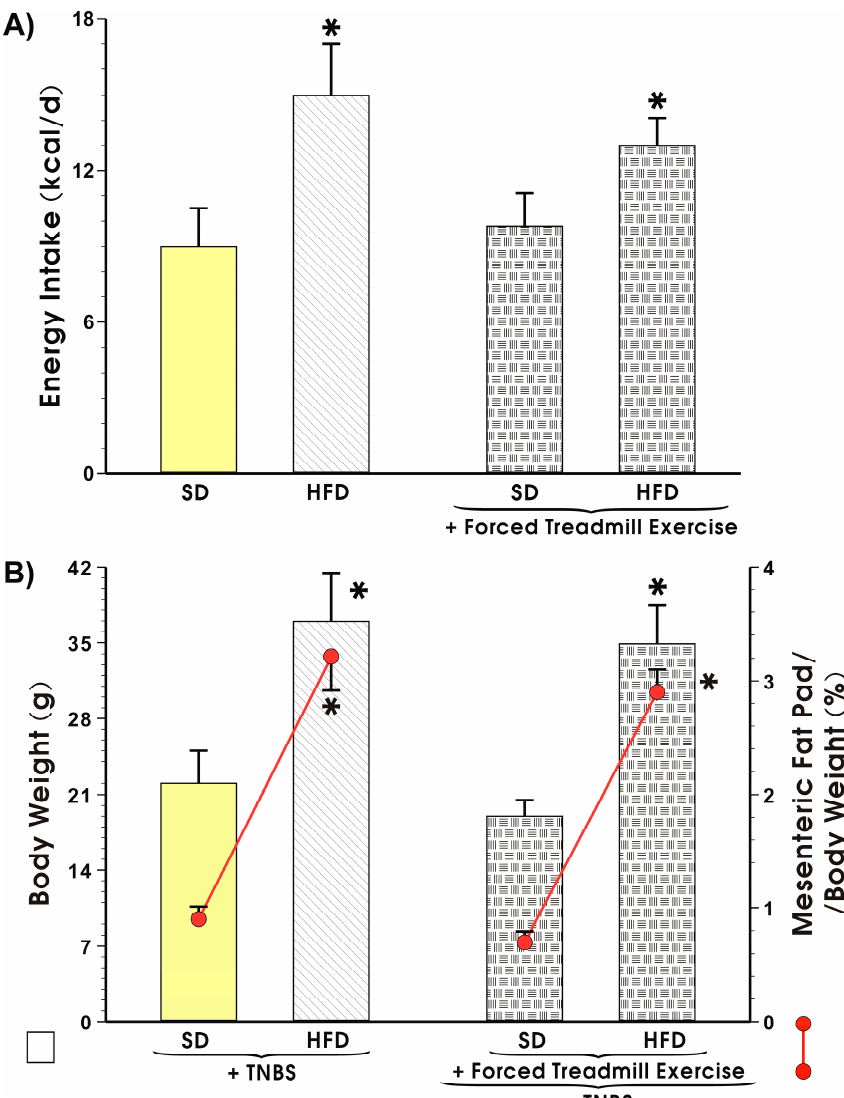
Figure 3. Effect of exercise on the energy intake ( A ), weight gain, and mesenteric fad pad ( B ) depicted as red line, in sedentary mice with TNBS-induced colitis fed SD or HFD with or without forced treadmill exercise. Results are Mean ± S.E.M. of 8 animals per each group. An asterisk indicates a significant change ( p < 0.05) as compared to respective values in sedentary mice fed SD.